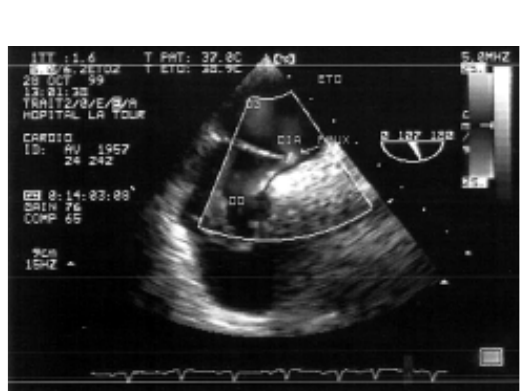
GUFFI, MEA - Surgical prophylaxis secundary to cryptogenic stroke or transient ischemic attack in patients with patent foramen